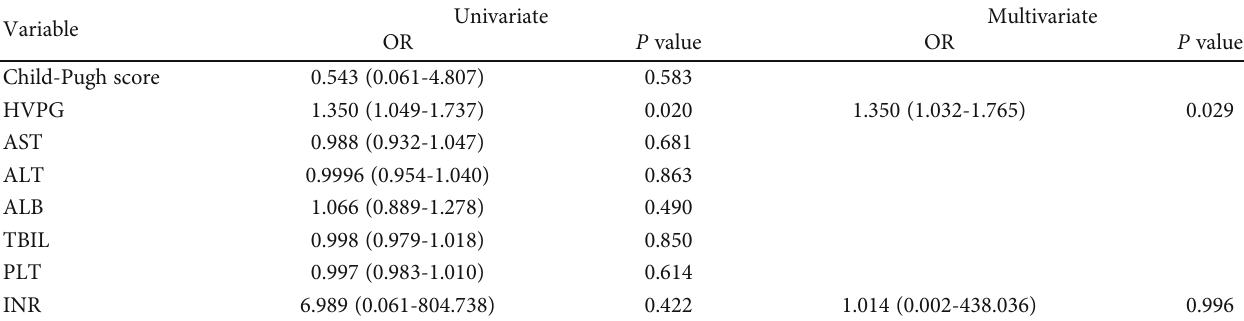
Table 2: Univariate and multivariate logistic regression analysis in the nonascites cohort.